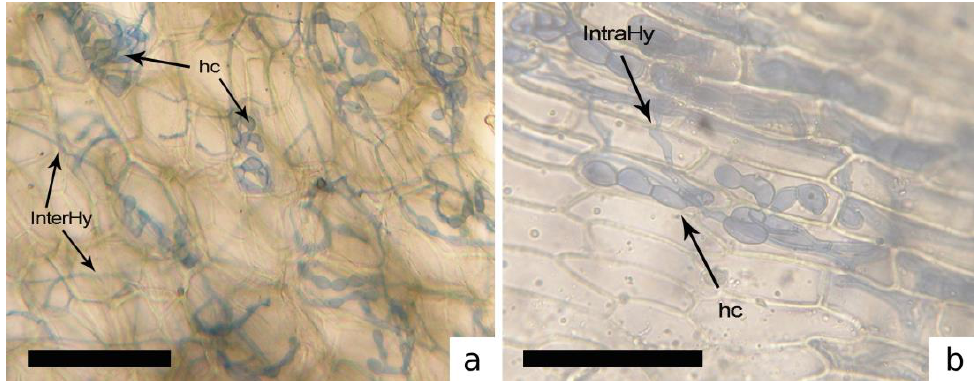
Figure 4. Inter- (InterHy), intracellular hyphae (IntraHy) and hyphae in coils (hc). of dark septate endophyte fungi (DSE). ( a ) Dumortiera hirsuta . ( b ) Hygroamblystegium varium . [Bars = 50 µm].